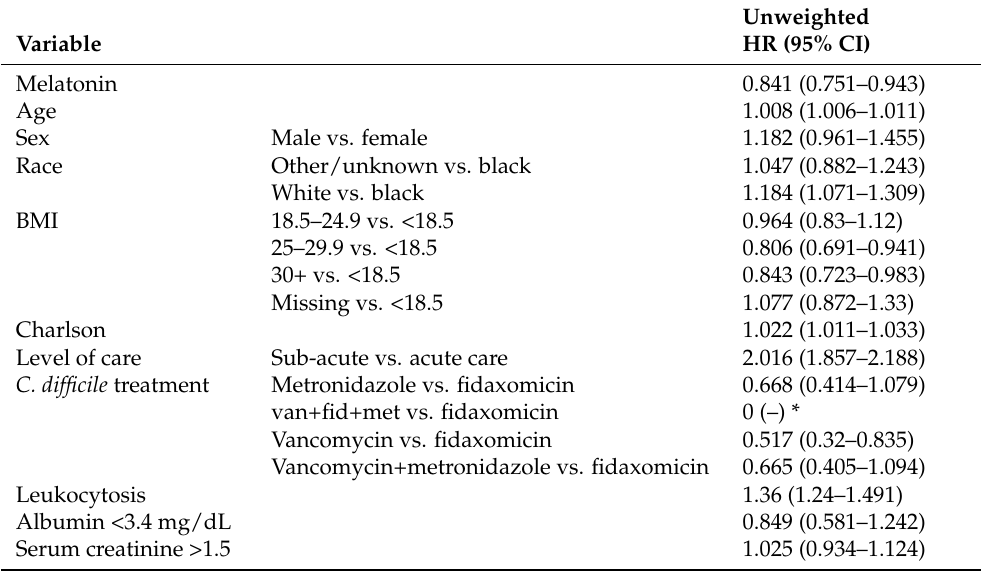
Table 2. Cox proportional hazards model evaluating the risk of recurrent Clostridioides difficile .